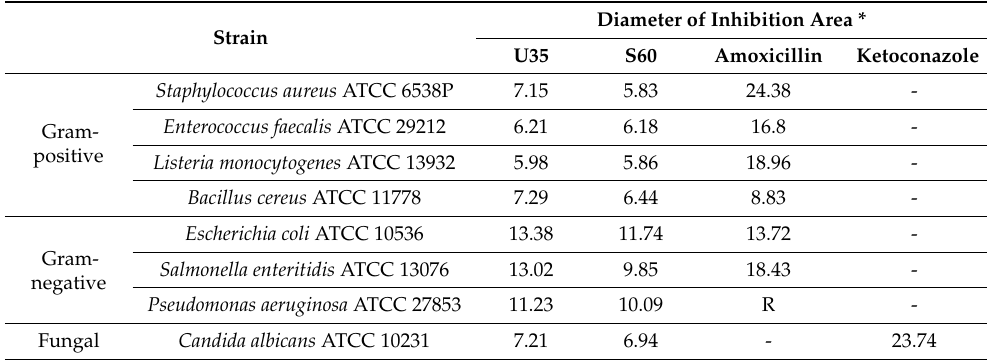
Table 5. Results for the in vitro qualitative study of antimicrobial activity (disk diffusion test).